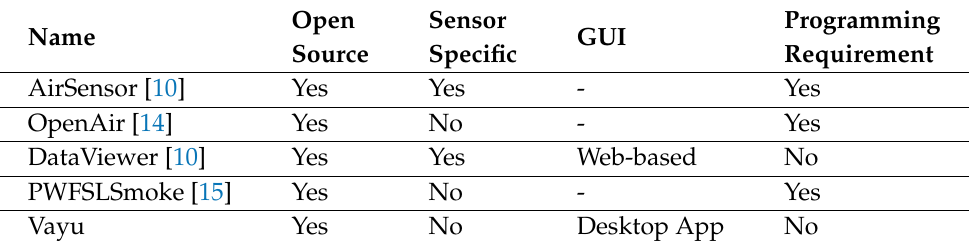
Table 1. Comparison of Vayu with other